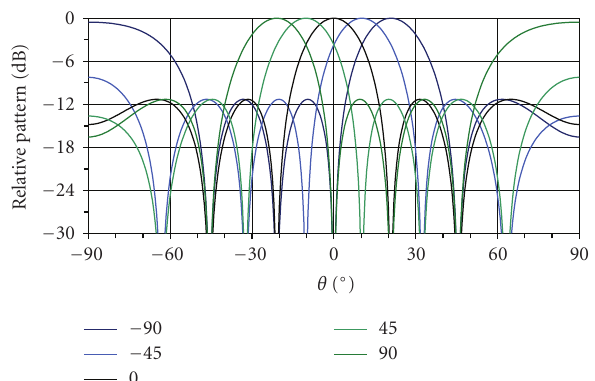
Figure 4: Five beams covering a 60 ◦ sector.